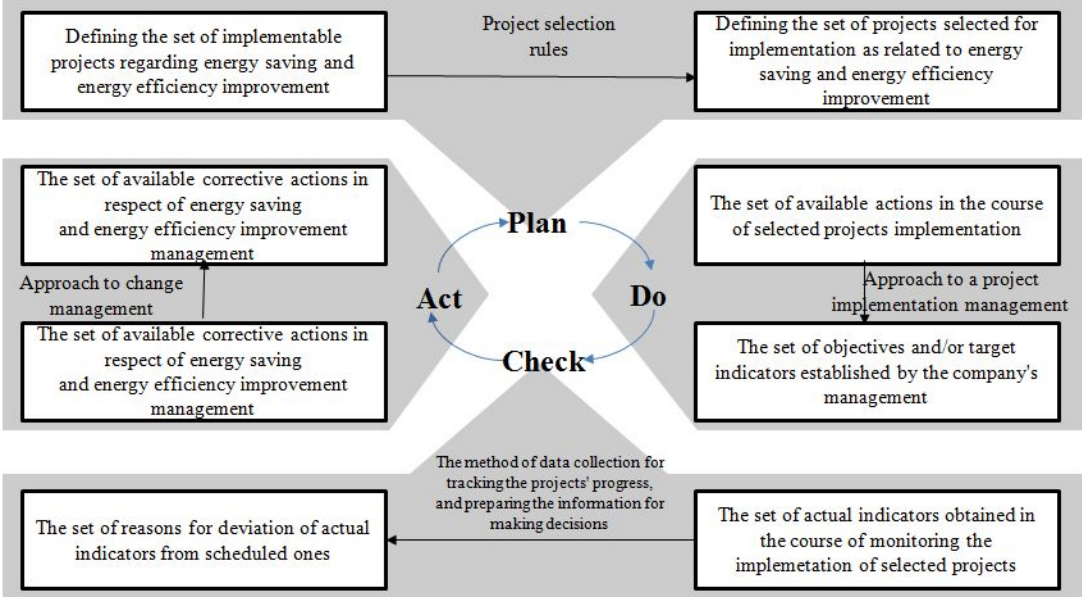
Figure 2. Basic process of managing energy saving and improvement of energy efficiency in the industrial company based on the "Plan–Do–Check–Act" continuous improvement cycle (source: compiled by the authors).